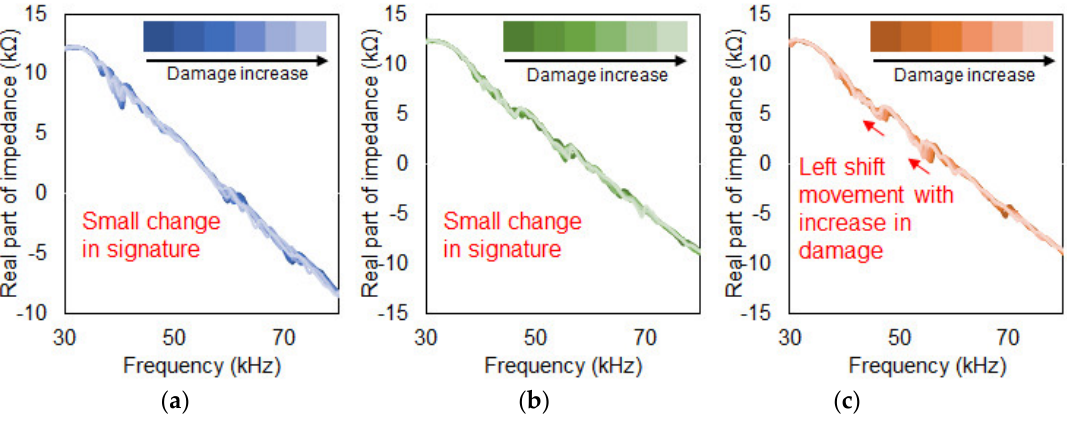
Figure 5. Delamination damage. ( a ) Conventional PZT attachment; ( b ) Steel wire PZT attachment; ( c ) Metal disc PZT attachment.